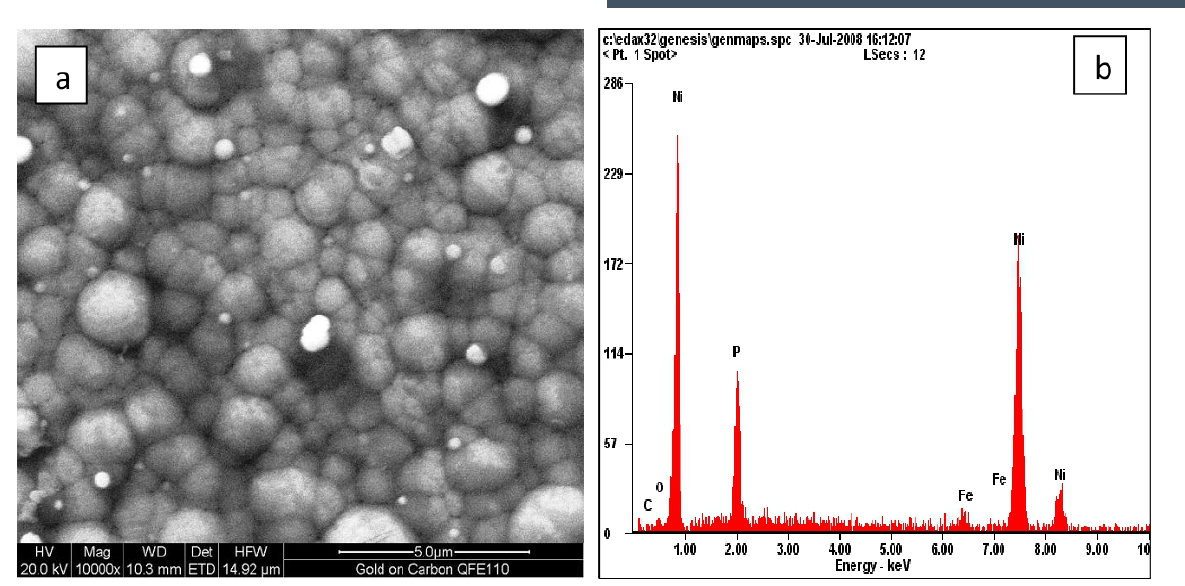
Figure 1. (a) SEM micrograph and (b) EDAX analysis of Ni-P coating on mild steel substrate.